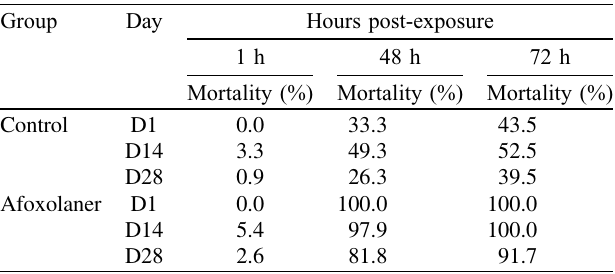
Table 2. Mortality % of fed female sand fl ies at 1, 48, and 72 h post- exposure.